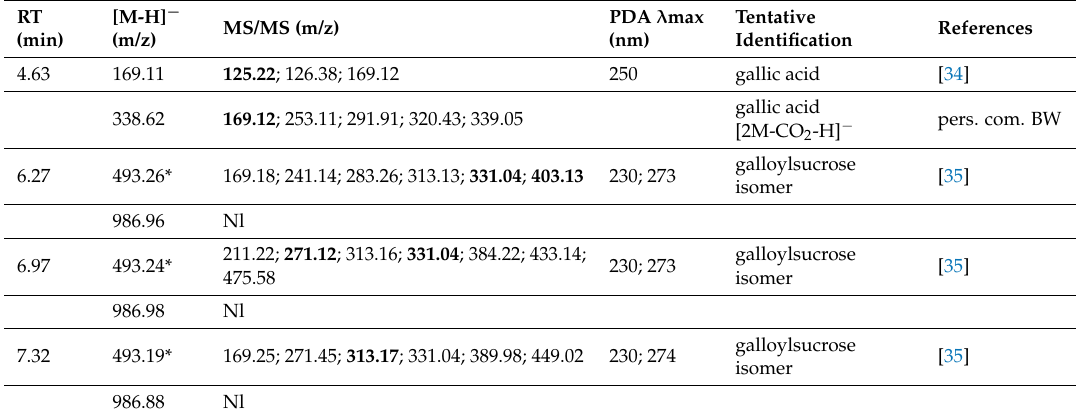
Figure 2. The photodiode array chromatogram (PDA) ( a ) and the total ion current (TIC) ( b ) of the P. lactiflora extract. The compounds listed in Table 2 correspond to the retention times of the TIC. Table 2. Retention times (RT), MS data, and tentatively identified compounds in the P. lactiflora extract.